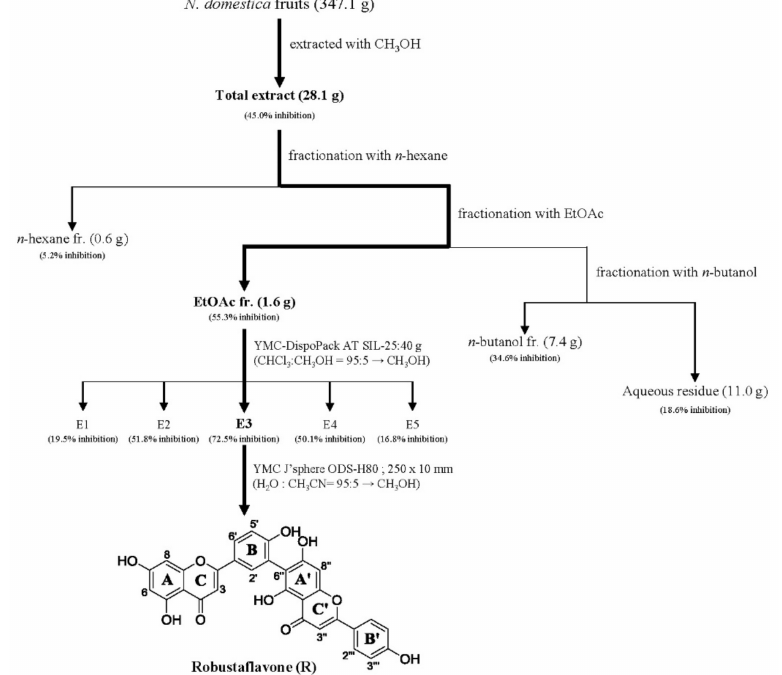
Figure 3. Schematic representation of the isolation of robustaflavone (R) from N . domestica fruits using bioactivity-guided fractionation. Bioactivity-guided fractionation of N. domestica fruit was performed as shown in the schematic representation and resulted in the isolation and identification of R. Fractionation was guided by assessing the inhibitory e ff ect of R on NO production at concentrations of 100 µ g / mL without any cytotoxicity. At each level of fractionation, all the fractions generated were tested simultaneously and were compared to the crude